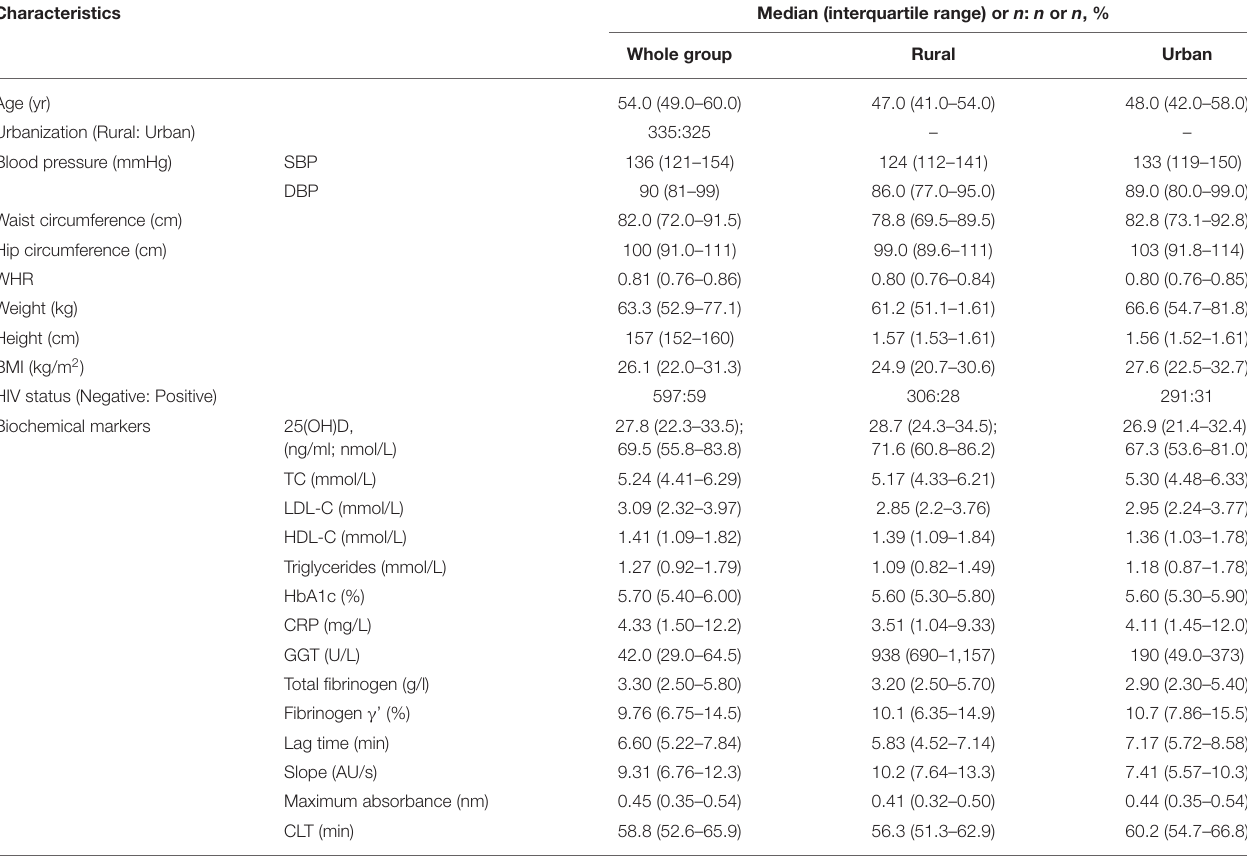
TABLE 1 | Specific characteristics of a group ( n = 660) of Black South African women.